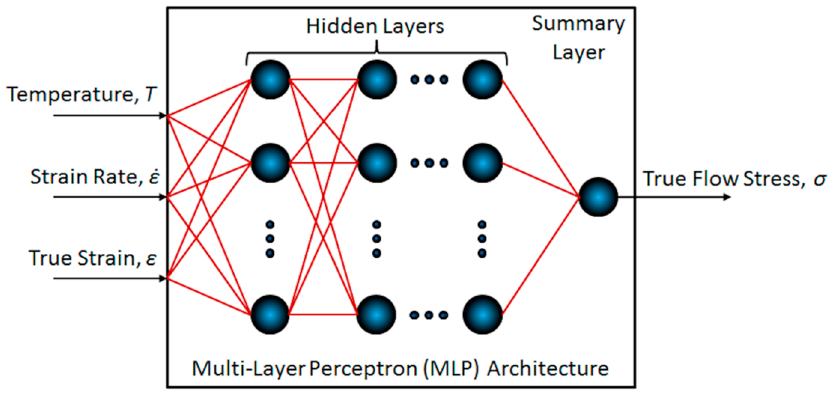
Figure 1. General architecture of the employed multi-layer perceptron (MLP) network.